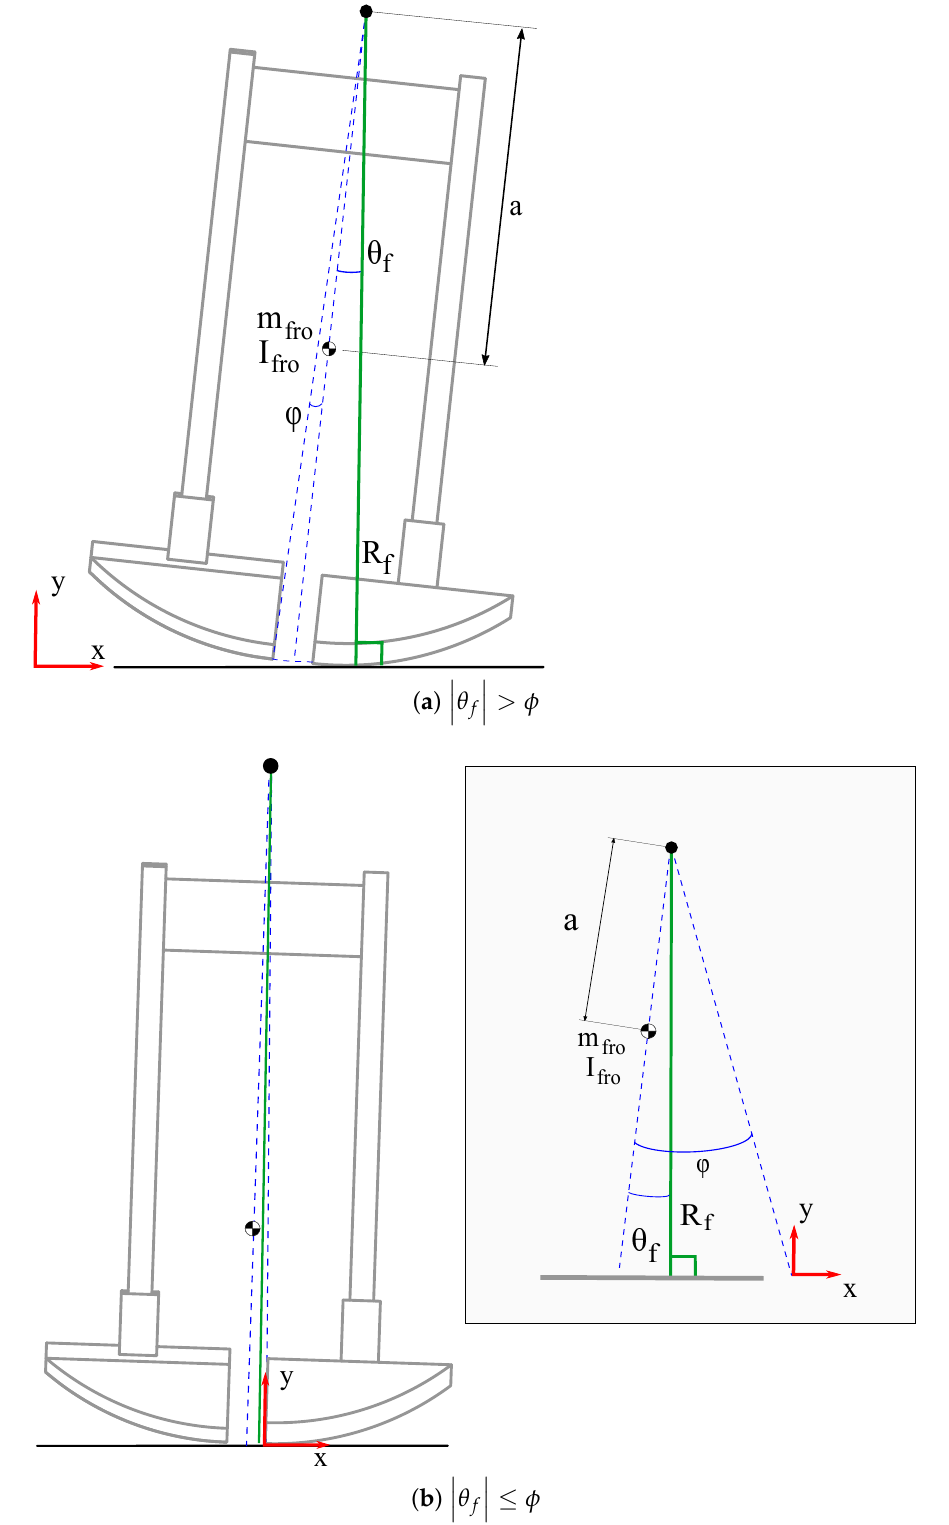
Figure 2. Frontal plane configuration of SPBR in single support